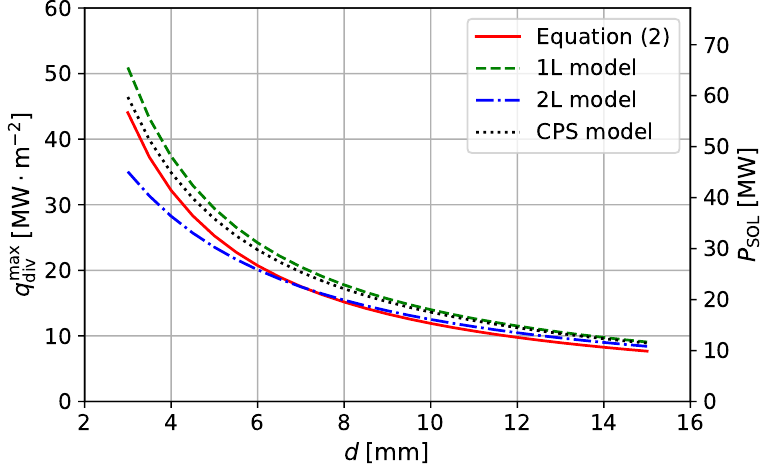
Figure 5. The maximum tolerable heat load q max as a function of target substrate thickness d . The div curves in the figure correspond to different target substrate models. The red solid line corresponds to the simplified approach based on Equation (2); the green dashed curve corresponds to a one- layer model; the blue dash-dotted curve corresponds to a two-layer model; the black-dotted curve corresponds to the CPS